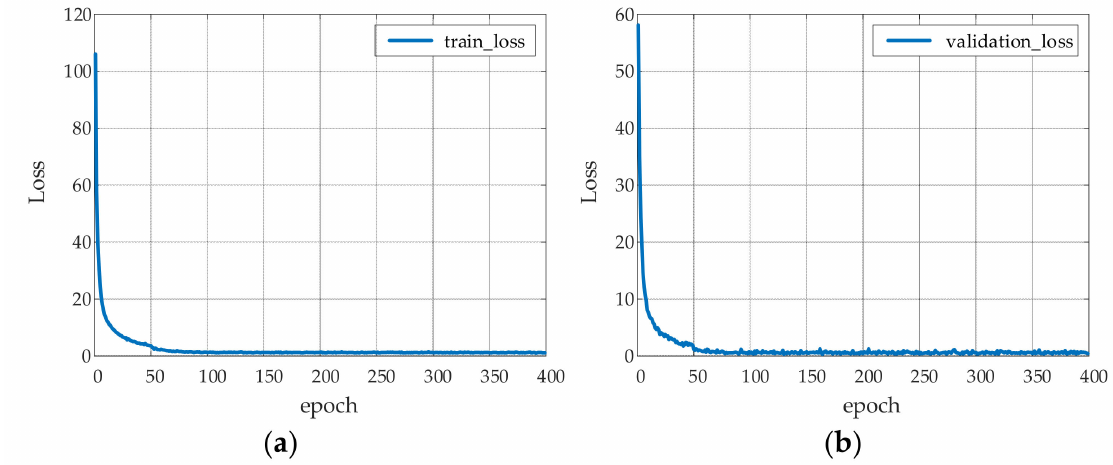
Figure 8. Loss function curves: ( a ) is the training loss of YOLOv4; ( b ) is the validation loss of YOLOv4.